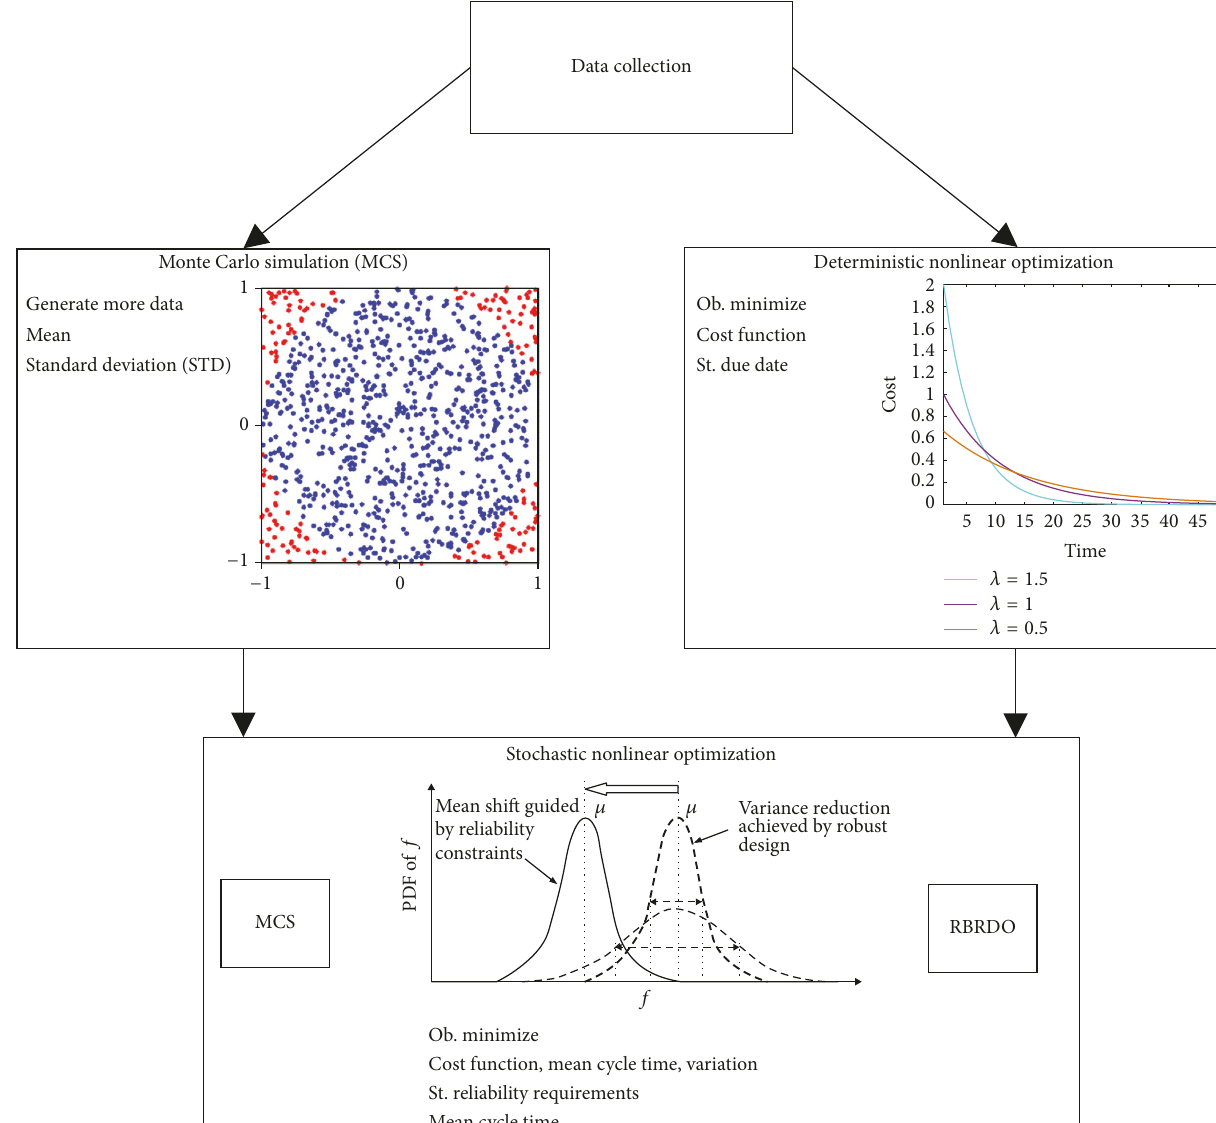
Figure 1: RBRDO procedure applied to an inventory management